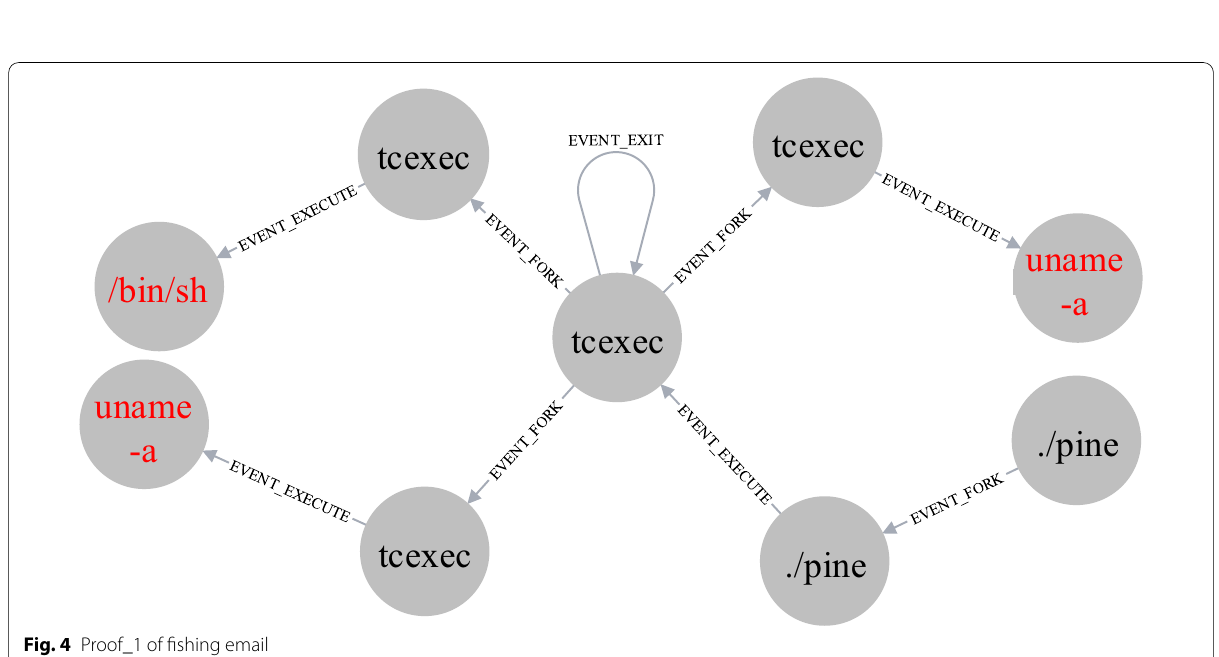
Fig. 4 Proof_1 of fishing